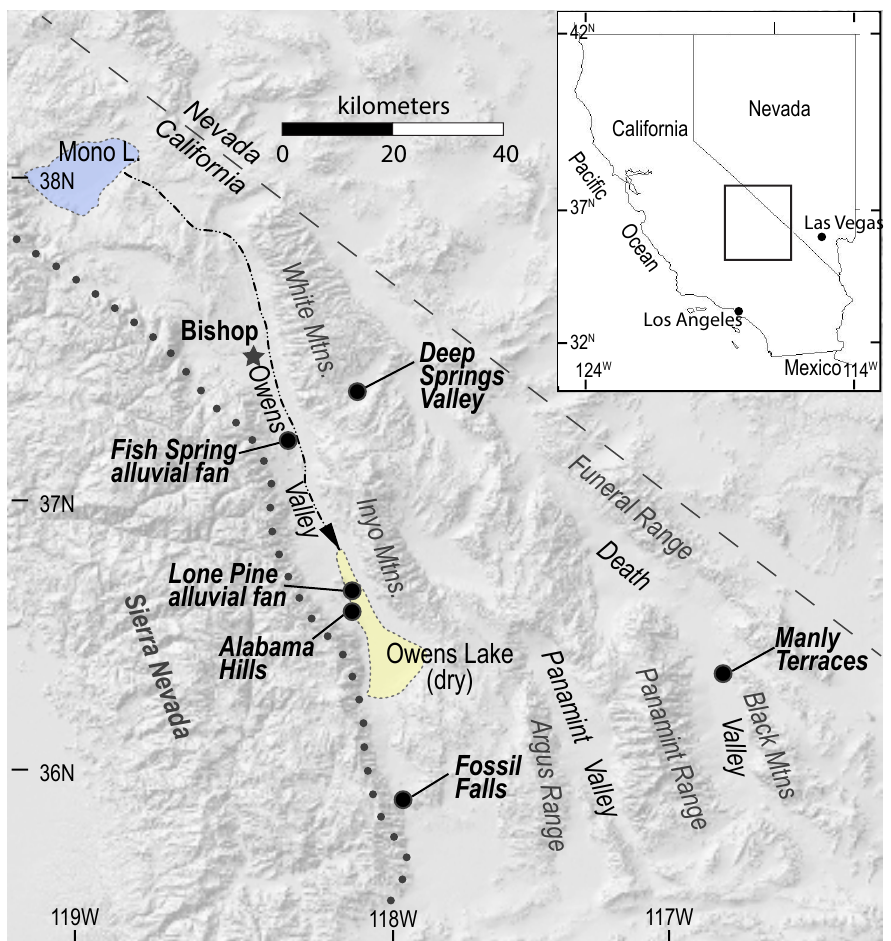
Figure 3. Shaded-relief map of eastern California and western Nevada showing the Manly Terraces, Fossil Falls, Alabama Hills, Lone Pine alluvial fan, Fish Springs alluvial fan and Deep Springs Valley sites sampled during this study. The western boundary of the Mojave Desert is indicated by the dotted line. The Owens River (black dashed line) flows in the southeasterly direction from Mono Lake (blue) to Owens Lake